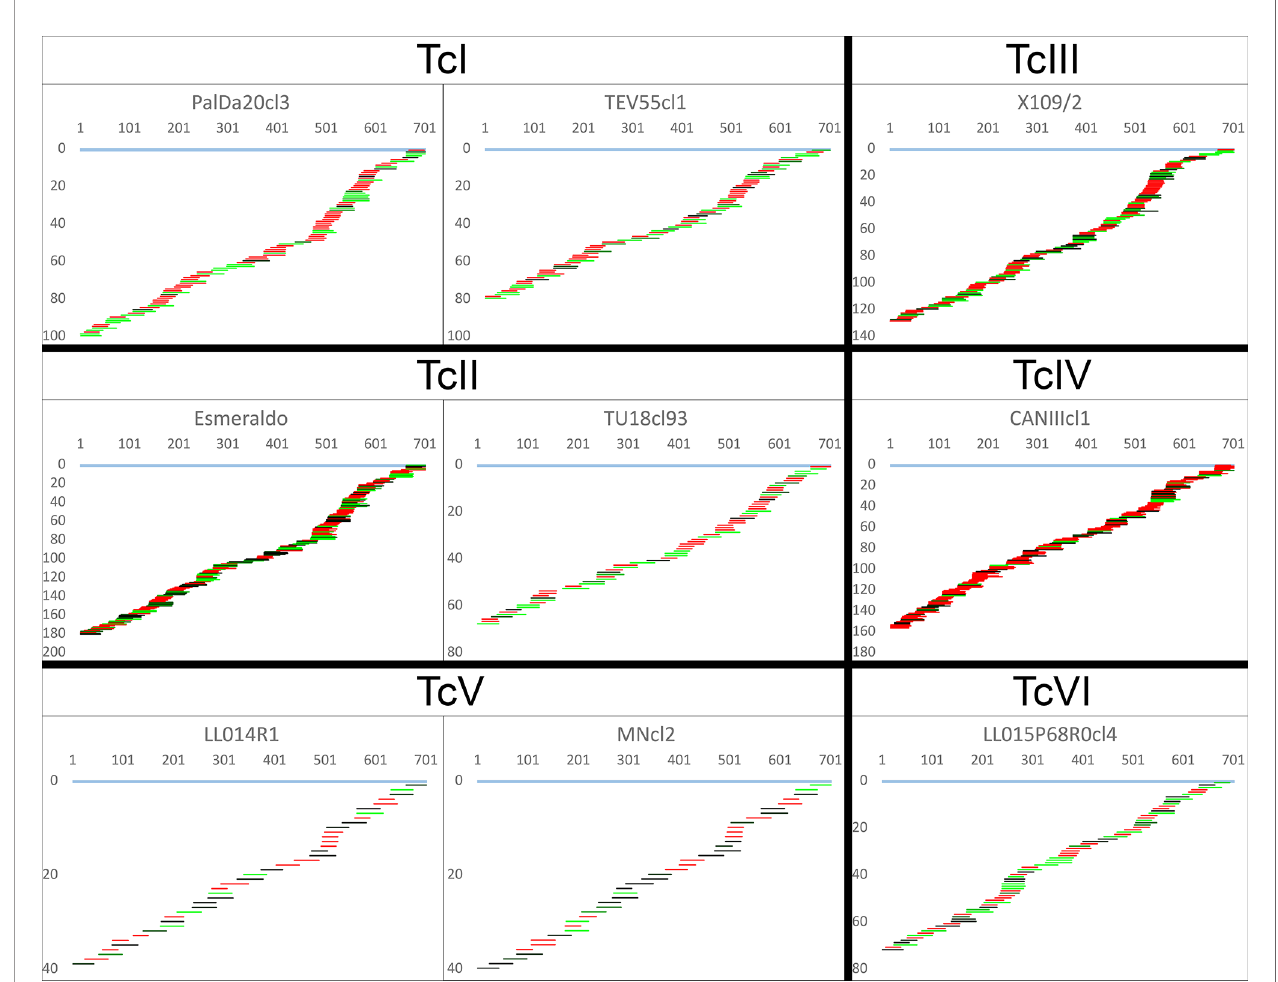
FIGURE 5 | Canonical ATPase6 mRNA editing cascade inferred from mHVR reads. gRNA classes are shown aligned below the fully edited mRNA (light blue). The x-axis indicates mRNA position, and the y-axis indicates the accumulated number of gRNA classes until such mRNA position. gRNA classes are colored based on sequence abundance as follow: red (1-19 reads), black to green (20-1,000 reads), light-green (>1,000